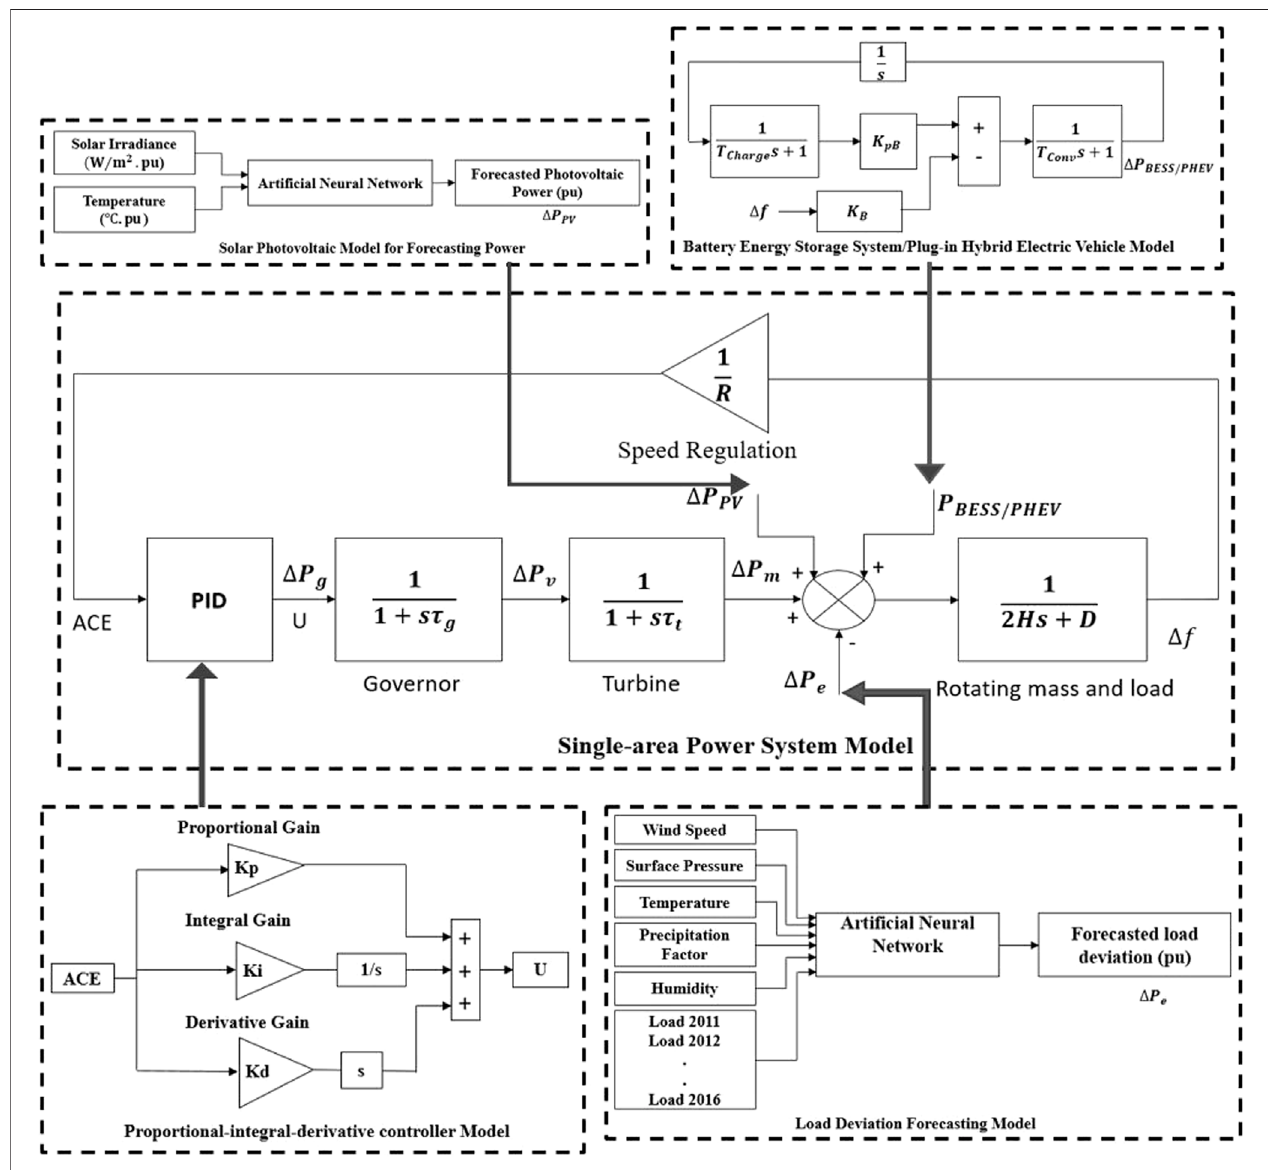
FIGURE 1 | Single-area power system